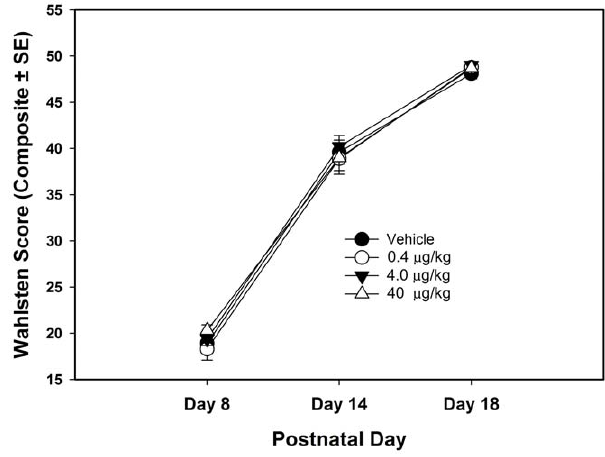
Figure 1. Neurodevelopmental composite score (sensory and motor development) for the four treatment groups. No group differences were statistically significant.